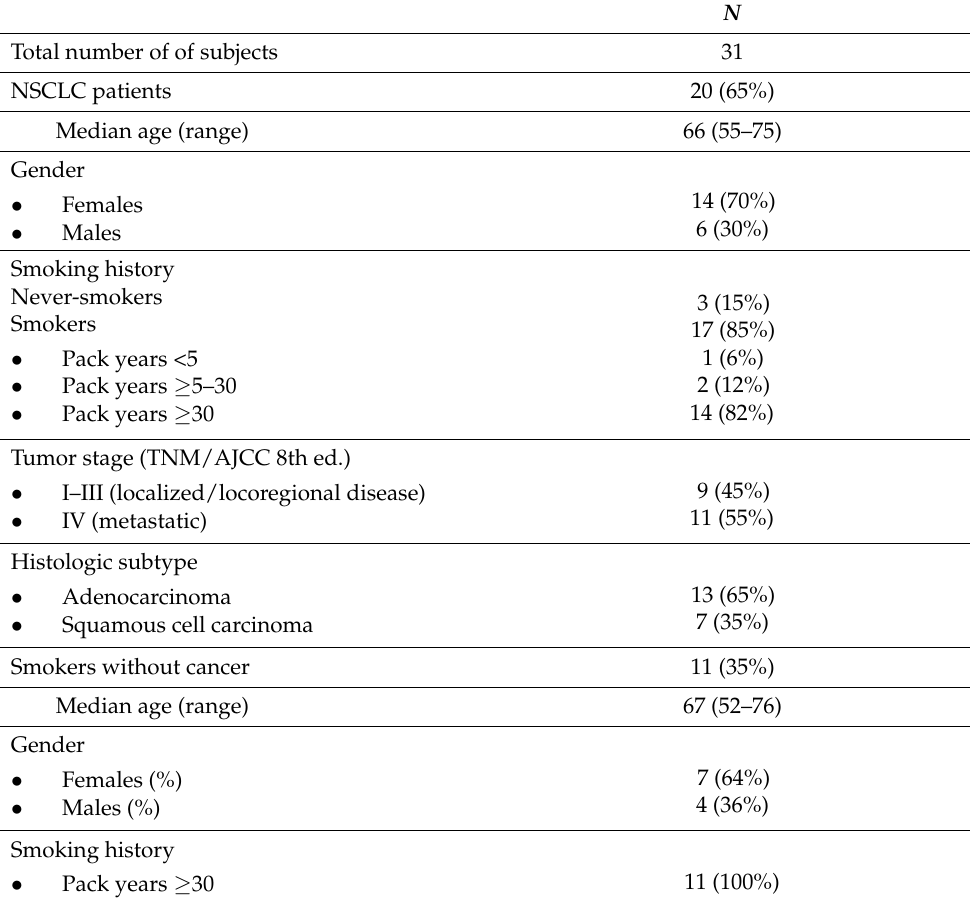
Table 1. Subjects’